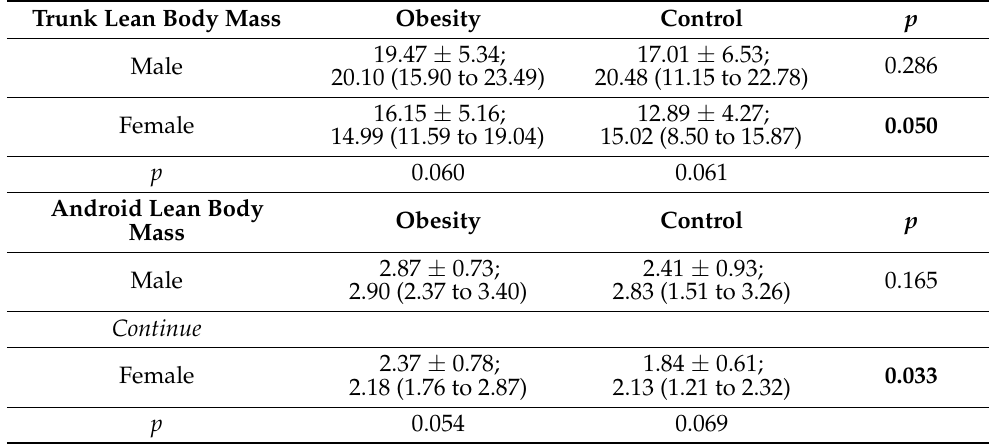
Table 7. Association between body composition (lean body mass) evaluated by dual-energy X-ray absorptiometry in groups of participants with and without obesity and according to